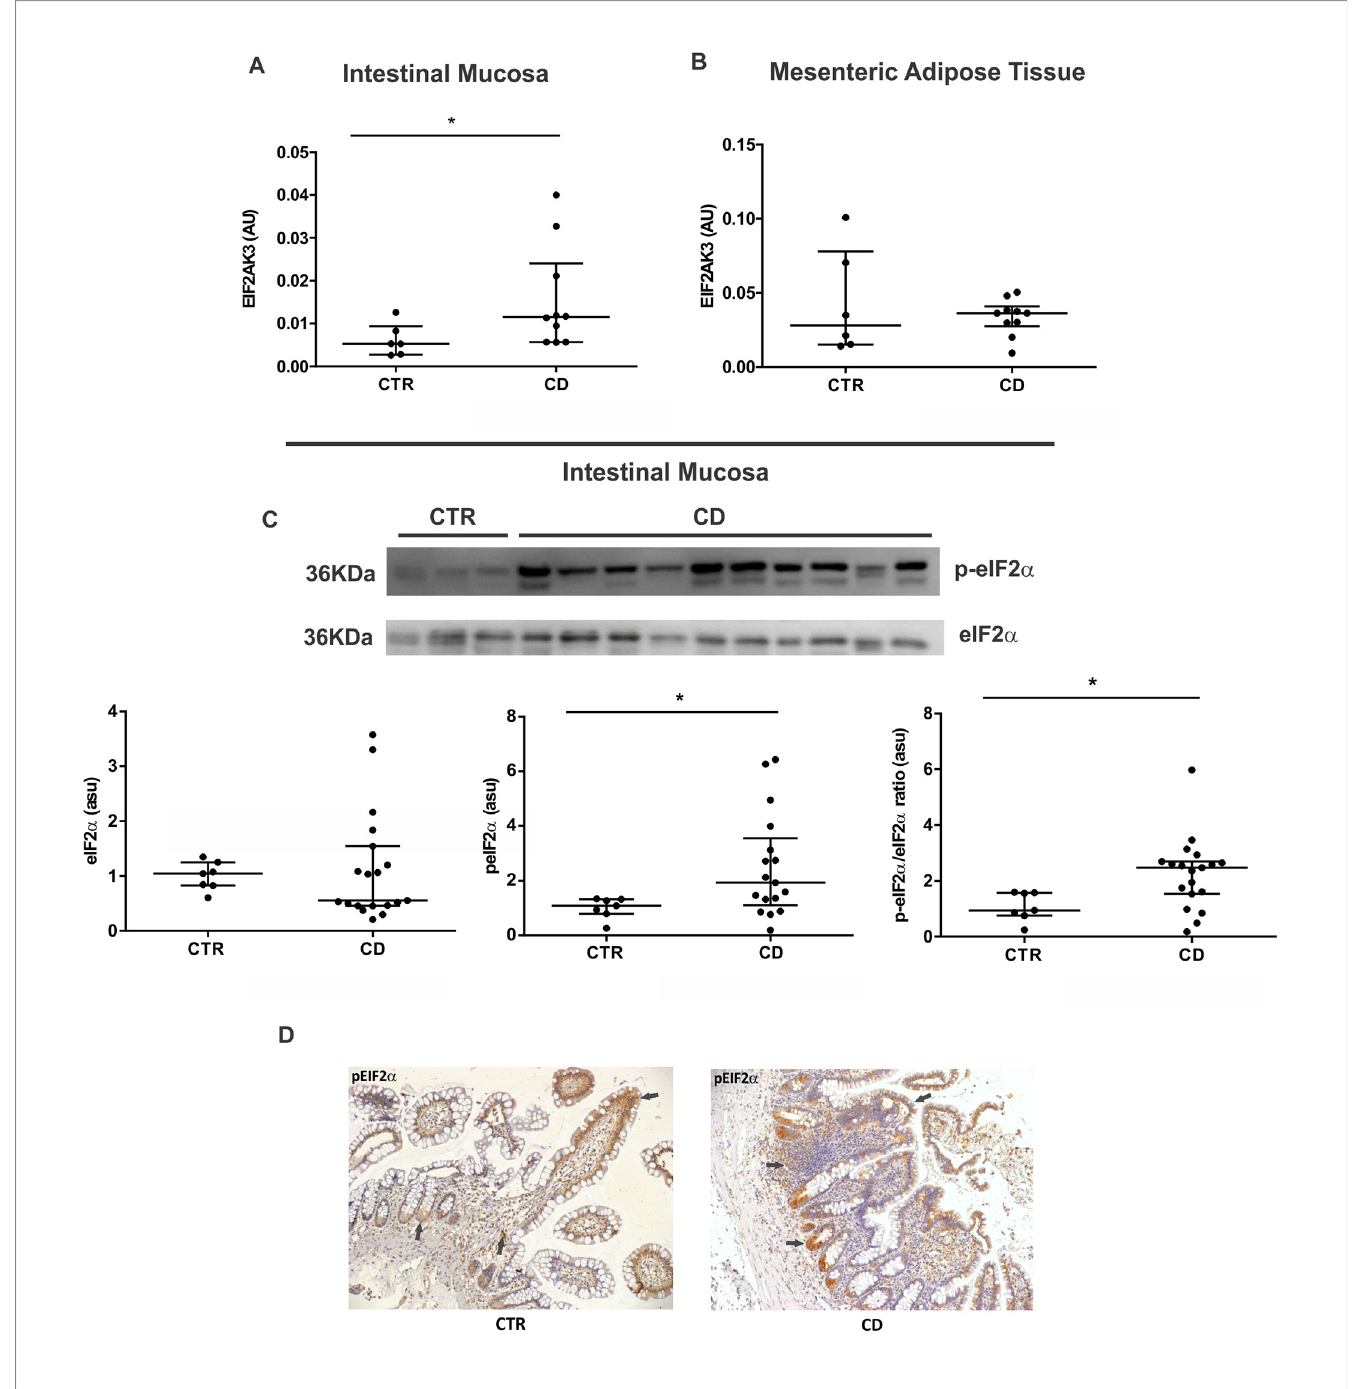
Fig 3. Activation of PERK/eIF2 α pathway in the intestinal mucosa and in the mesenteric adipose tissue (MAT) of Crohn’s disease patients. mRNA levels (qRT-PCR) of EIF2AK3 gene was investigated in the intestinal mucosa (A) and in MAT (B) of CD patients (CD group) compared to control group (CTR group). � p < 0.05 and �� p < 0.01 are considered statistically significant versus control group. Western blot analysis of phosphorylated and total form of the protein eIF2 α (C), was evaluated in the intestinal mucosa of CD patients (CD Group) compared to controls (CTR Group). Each band represents one patient. � p < 0.05 and �� p < 0.01 are considered statistically significant versus control group. Immunohistochemical analysis of p-eIF2 α was performed on paraffin-embedded slides from intestinal mucosa of CD and CTR group. The arrows show labeled epithelial cells by immunohistochemistry. Original magnification 100X (D). AU: arbitrary unit. ASU: arbitrary scanning